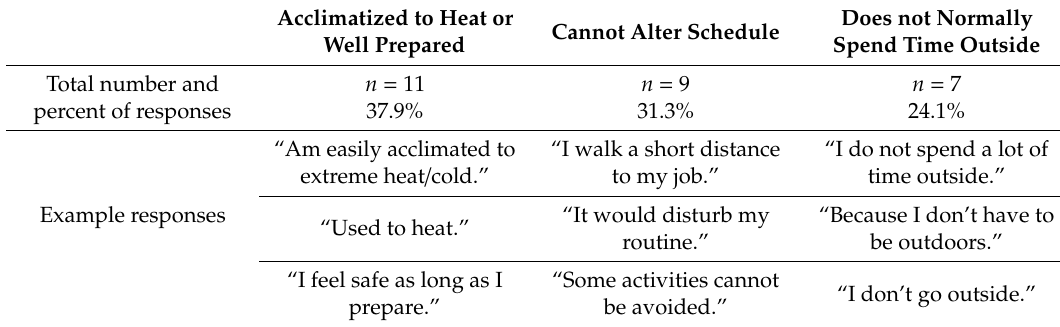
Table 6. Examples of open-ended responses to the survey question, “Why do you not change or move daily activities on hot days?” ( n =